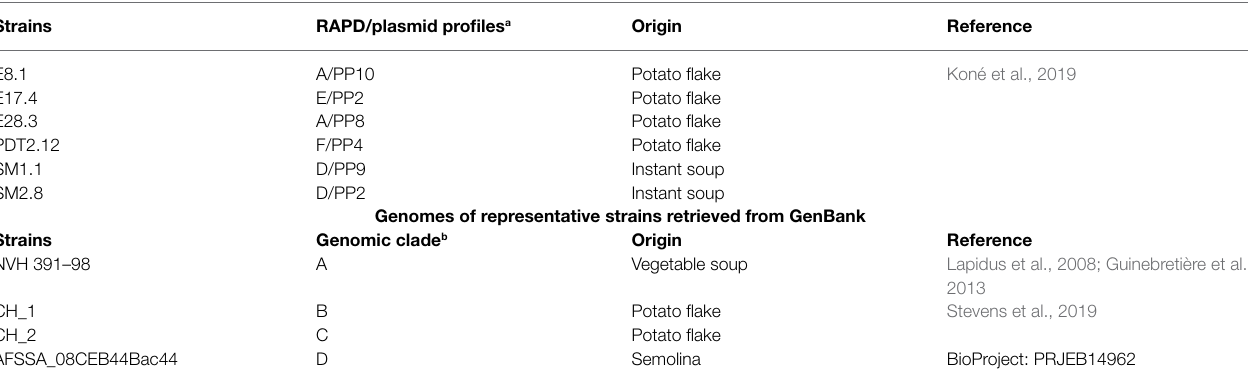
TABLE 1 | Origin and main features of the Bacillus cytotoxicus strains used in this study.